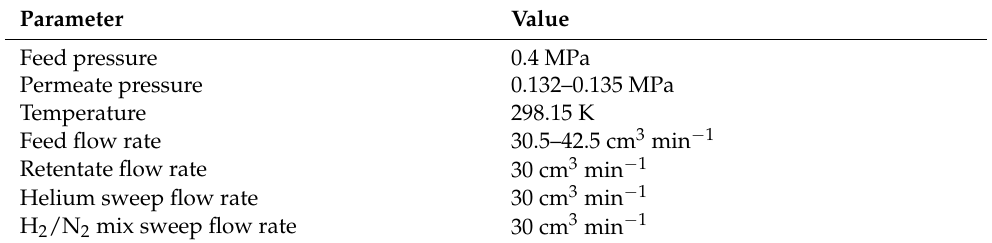
Table 3. Membrane-assisted gas absorption process experimental